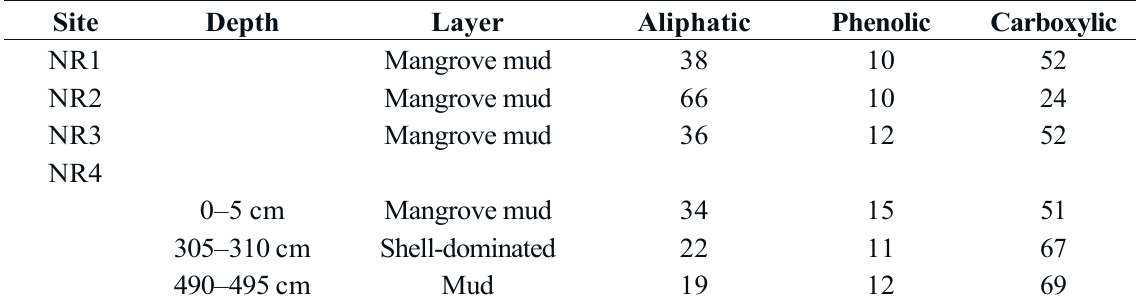
Table 8. Compositions (%) of humic acids at different sites and